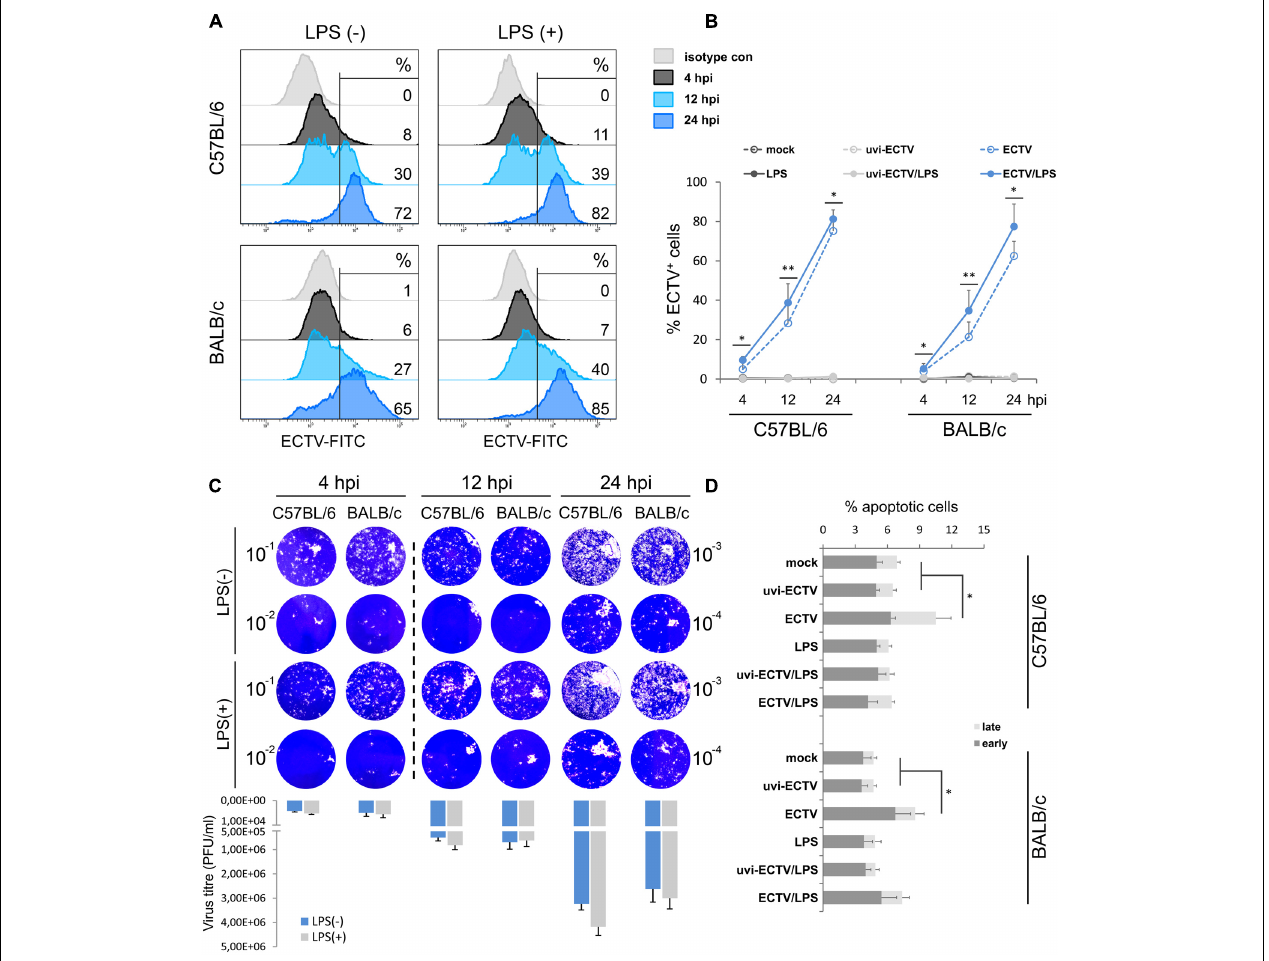
FIGURE 1 | Similar kinetics of ECTV replication in GM-BM of C57BL/6 and BALB/c mice. (A) Representative flow cytometry histograms showing the percentage of ECTV + cells at 4, 12, and 24 hpi of GM-BM. (B) The percentage (mean ± SD) of ECTV + cells in GM-BM culture. (C) Plaque assay determination of ECTV titer in GM-BM at 4, 12, and 24 hpi. Plaques were visualized by staining of Vero cell monolayers with 0.3% crystal violet. The mean number of infectious virions (PFU/ml) was calculated from two experiments. (D) The percentage (mean ± SD) of early and late apoptotic cells in GM-BM during ECTV infection (Student’s t -test; ∗ P < 0.05, ∗∗ P <